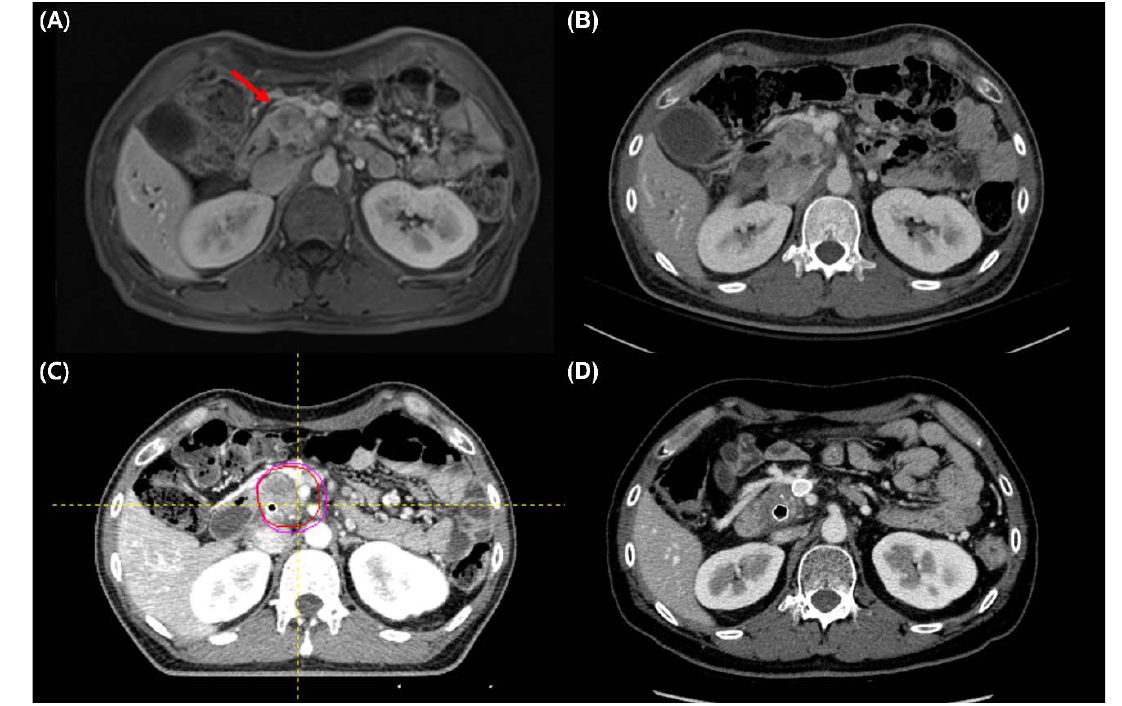
Figure 3. A representative patient who underwent curative resection after stereotactic body radiation therapy (SBRT). ( A , B ) Pre-SBRT magnetic resonance imaging and computed tomography (CT) show pancreatic head cancer (red arrow) abutting more than 180° of the superior mesenteric artery (SMA). ( C ) Gross tumor volume and planning target volume in simulation CT. ( D ) Three months follow-up CT after SBRT shows decreased tumor and SMA